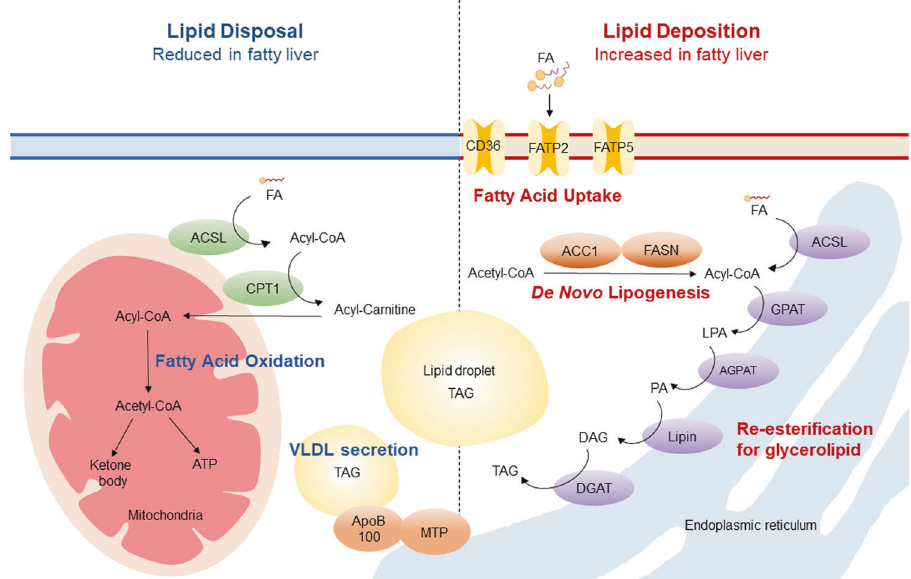
Fig. 1 Hepatic lipid metabolism in fatty liver. Circulating FAs are imported via FATPs, including CD36, FATP2, and FATP5. ACSL converts the FAs taken up by cells to acyl-CoA, which is further reesteri fi ed to produce glycerolipids, mainly in the ER. In addition, FAs can be synthesized via DNL using acetyl-CoA. These intracellular FAs can be consumed to generate VLDL by forming a complex with ApoB100 via MTP. Furthermore, FAs are cleaved to generate acetyl-CoA through FA oxidation in the mitochondria to produce ATP and ketone bodies. An imbalance between lipid disposal and storage promotes fatty liver